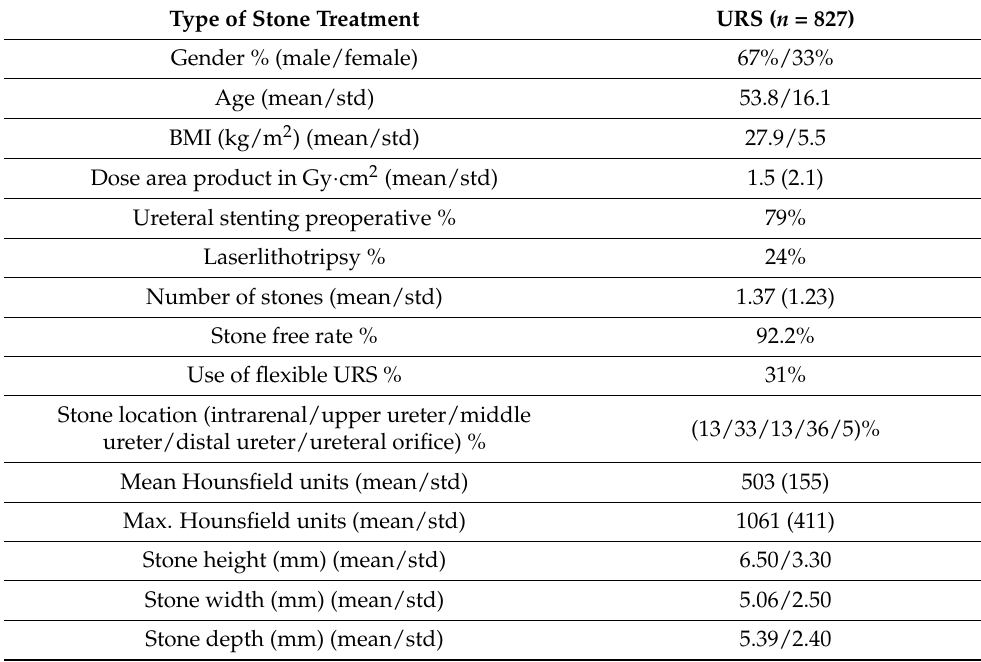
Table 1. Patient demographics for URS.